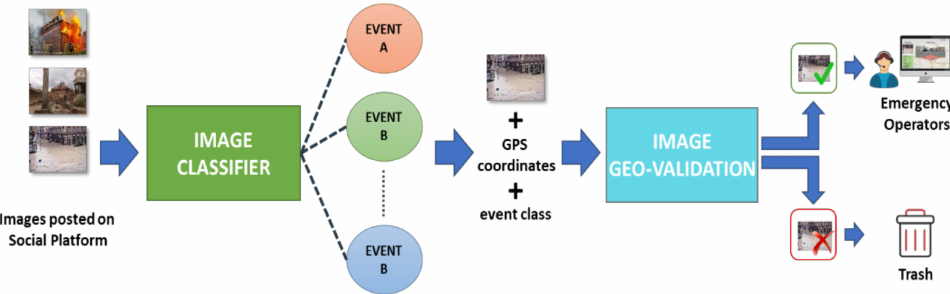
Figure 5. Logical architecture of the IDA module with the two main sub-modules: the Image Classifier and the Image Geo-validation.